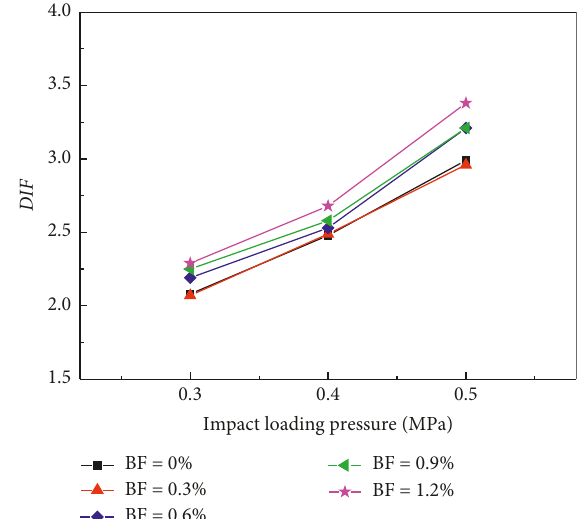
Figure 14: Dynamic increase factor of stabilized